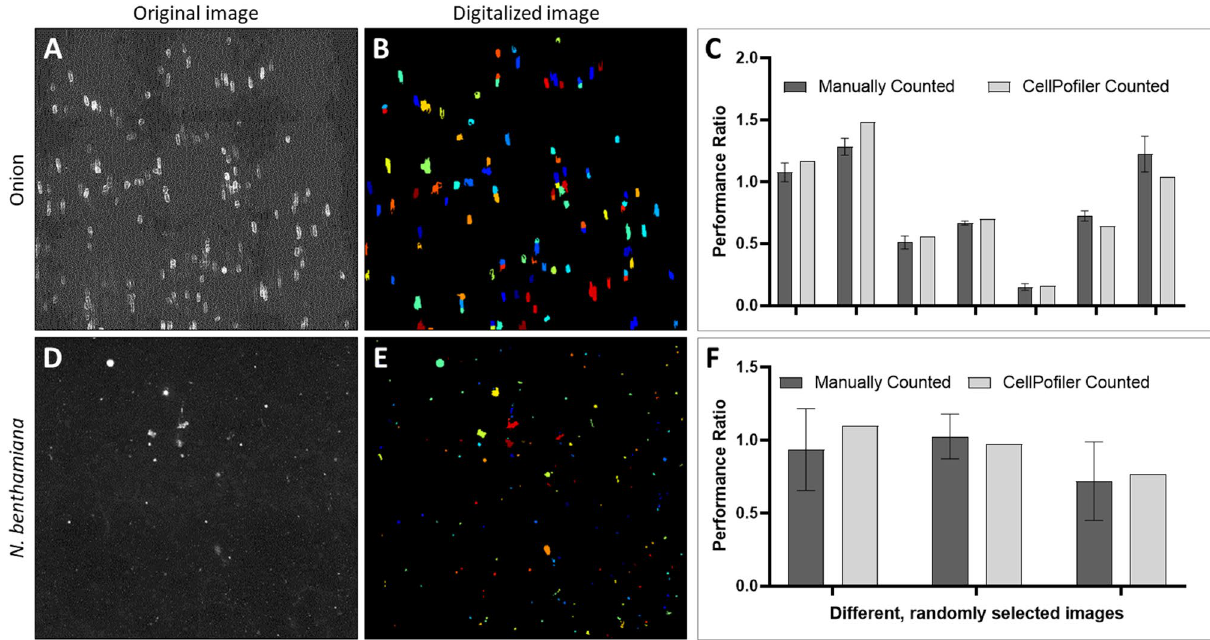
Figure 3. Algorithm validation. ( A ) The original image of the GFP fluorescent onion cells, shown in black and white to reflect the greyscale nature of the CellProfiler algorithm; ( B ) an image produced by the CellProfiler counting, showing which cells were counted by the software. Different colors indicate distinct cells; ( C ) statistics comparing the performance ratio of several randomly selected images counted by hand as well as by the software. Note that the CellProfiler counts have no error bar as the software is self-consistent, which is in contrast to the manual counting; ( D – F ) the protocol for counting cells was optimized and repeated for N. benthamiana cells, which includes both epidermis and trichome